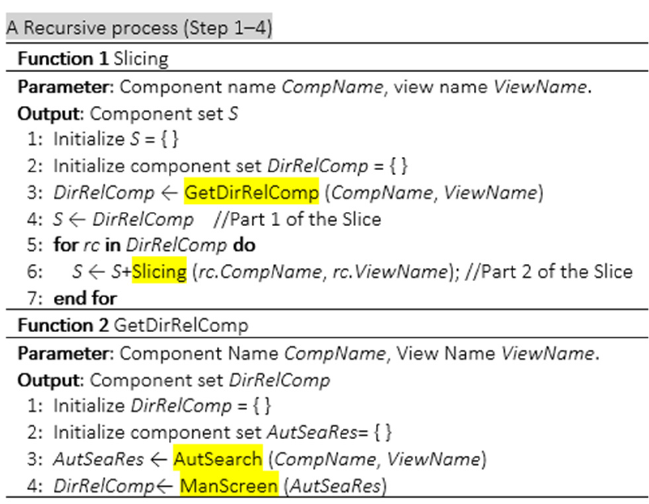
Figure 2. Pseudo-codes for the overall recursive slicing process (Step 1–4).